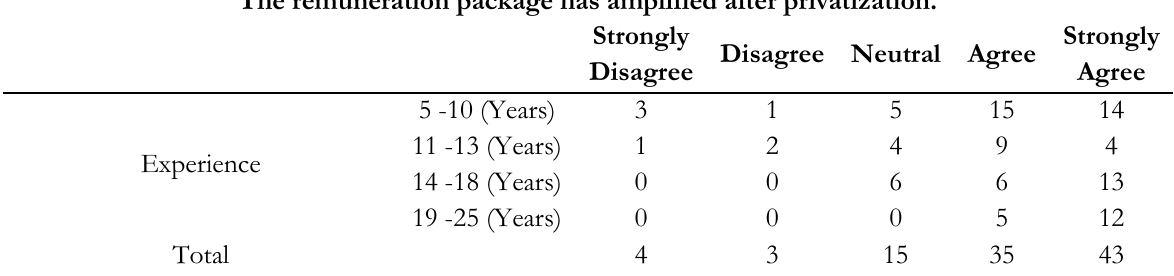
Table 6: EXP * Q7 Cross tabulation The remuneration package has amplified after privatization.